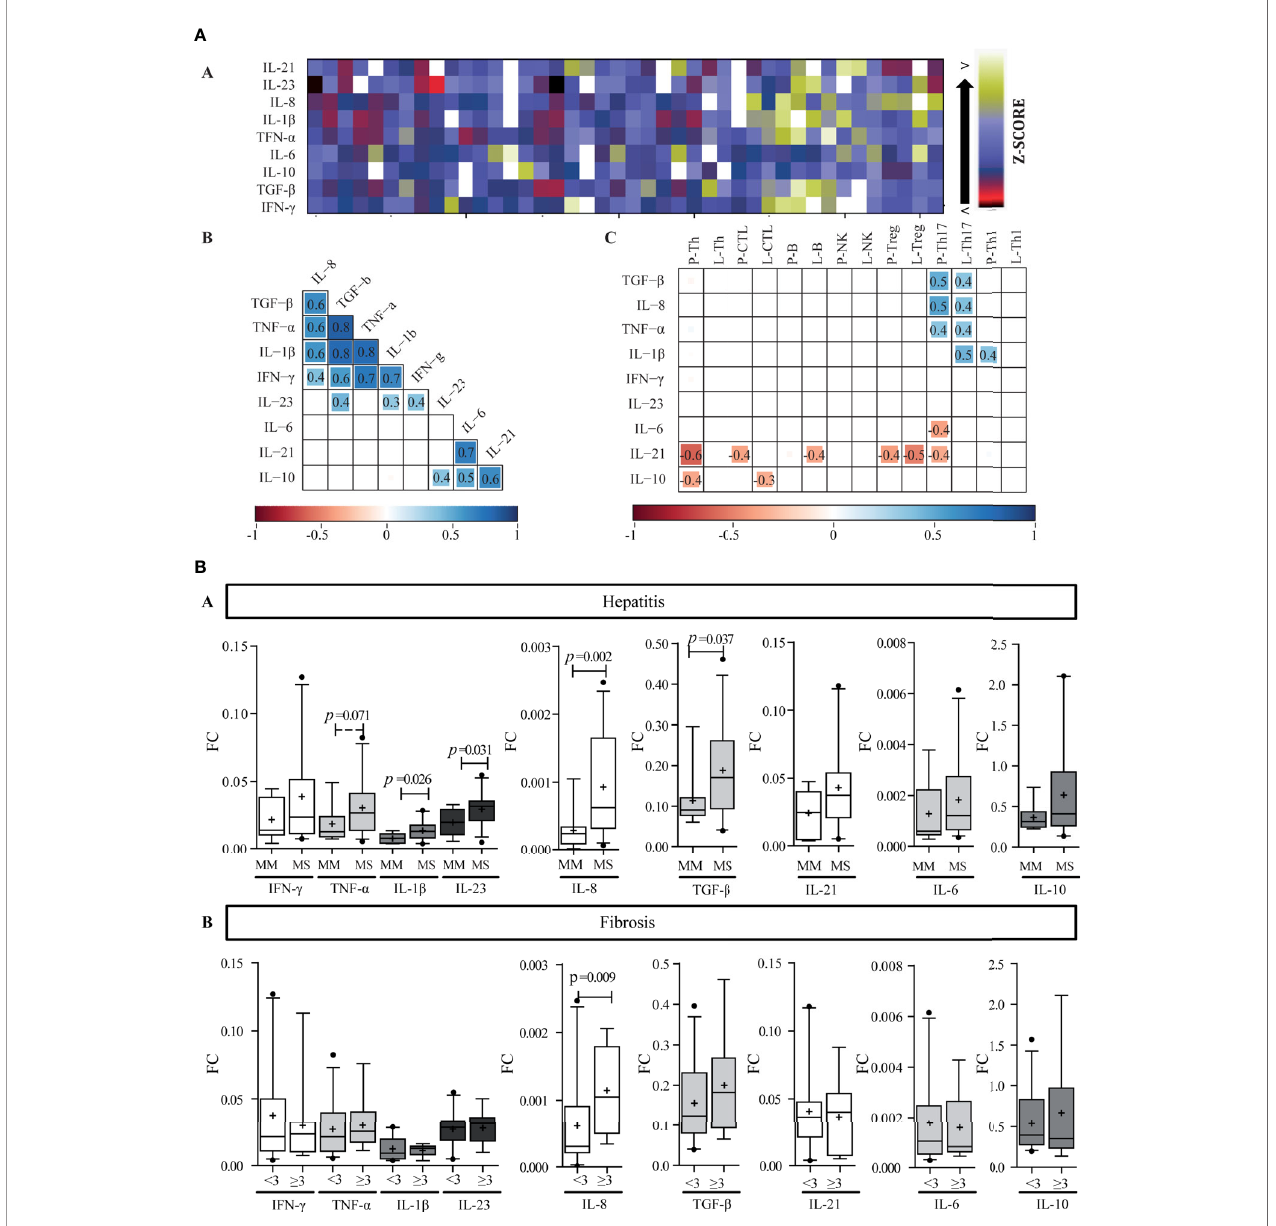
FIGURE 4 | Liver cytokine expression level. (A) Heat map of liver cytokine expression level (a). Each row corresponds to the cytokine indicated at the top, and each column represents one case. The data are normalized, and the results are expressed as a Z-score (Xi-/SD), which is assigned a color scale that goes from black (lowest values) to yellow (highest values). The white boxes correspond to the cases without data. Correlation matrix of cytokines (b) and correlation matrix between in fi ltrate cell populations and intrahepatic cytokine levels (c). (b, c) are schematic representation: the numbers inside the boxes indicate the Spearman correlation coef fi cients (r) only for those pairs of cytokines that show statistical signi fi cance ( p < 0.05). The squares inside the boxes graphically represent the value of r: the light blue color indicates r values between 0 and 1 (positive correlation), and the red color indicates values between − 1 and 0 (negative correlation), while its size increases as r increases towards values close to |1|. - P, portal – periportal; -L, lobular. Panel (B) Relationship between intrahepatic cytokine levels and liver damage. Expression levels of intrahepatic cytokines in relation to hepatitis (a) and fi brosis (b) severity. MM, minimal – mild; MS, moderate – severe hepatitis. Advanced fi brosis (F ≥ 3) according to METAVIR. The results are depicted in box plots. Horizontal lines within boxes indicate medians. Horizontal lines outside the boxes represent the 5 and 95 percentiles. Mean is indicated as +. FC, fold change. Mann – Whitney U test was used to compare all data sets, except for IL-1 b and IL-23 vs. hepatitis severity for which Student ’ s t-test was